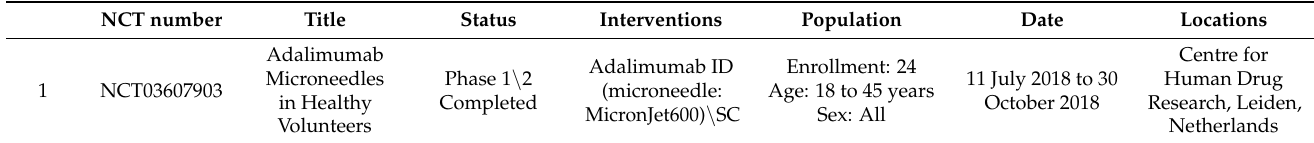
Table 5. Current clinical trials of microneedle delivery of arthritis